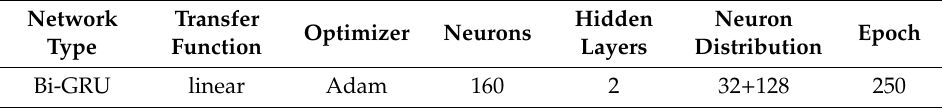
Table 1. Hyper-parameters of the Bi-GRU